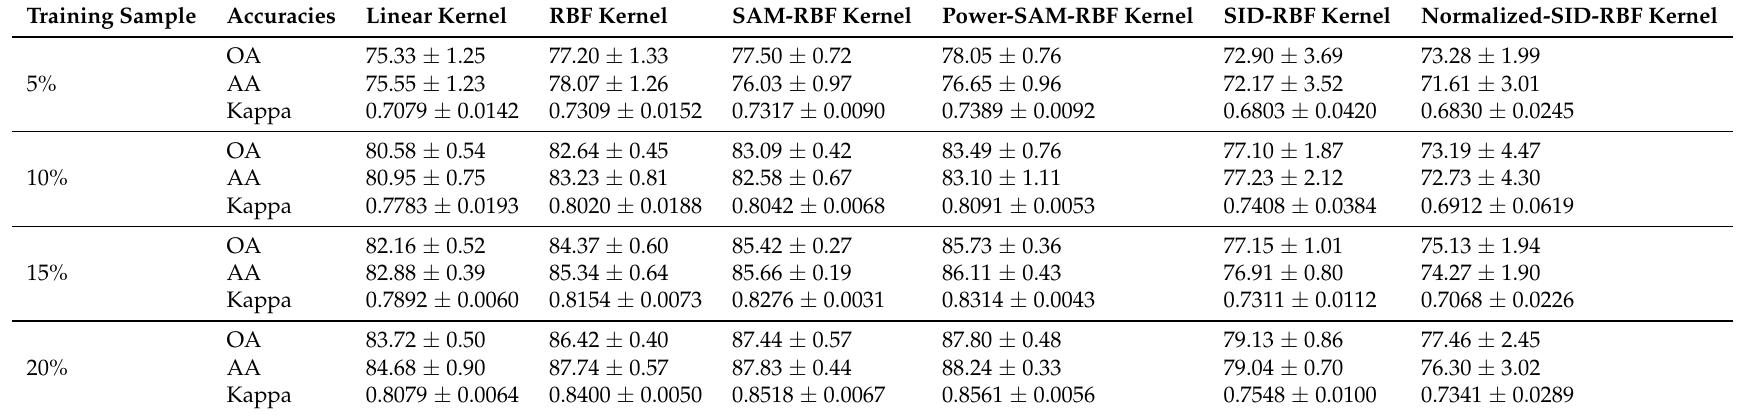
Table 3. Overall accuracies (OA), average accuracies (AA), kappa coefficients of Linear, RBF, SAM-RBF, Power-SAM-RBF, SID-RBF, and Normalized-SID-RBF kernels on the Indian Pines